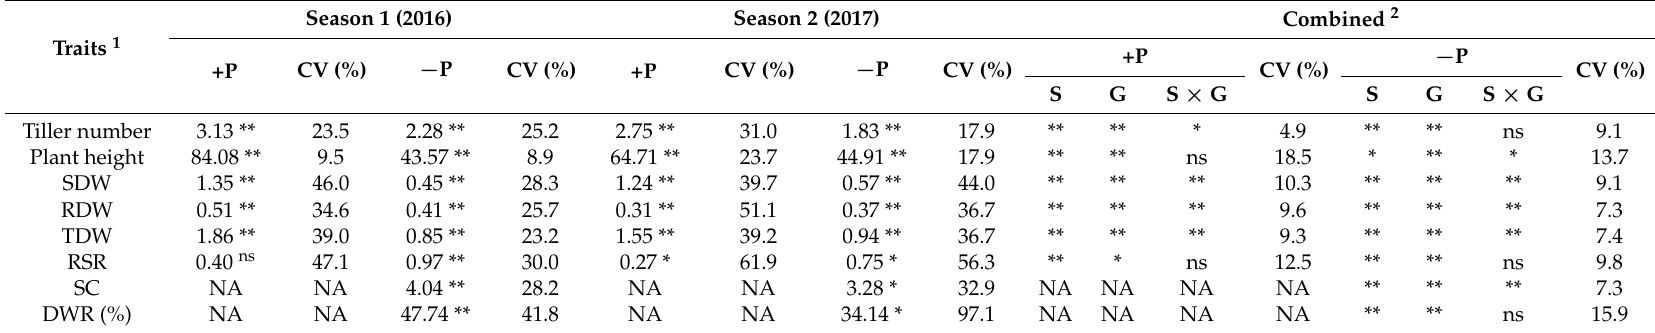
Table 1. The means of observed traits under sufficient phosphorus (+P) and deficient phosphorus ( − P) conditions, as compared by analysis of variance in each season and in